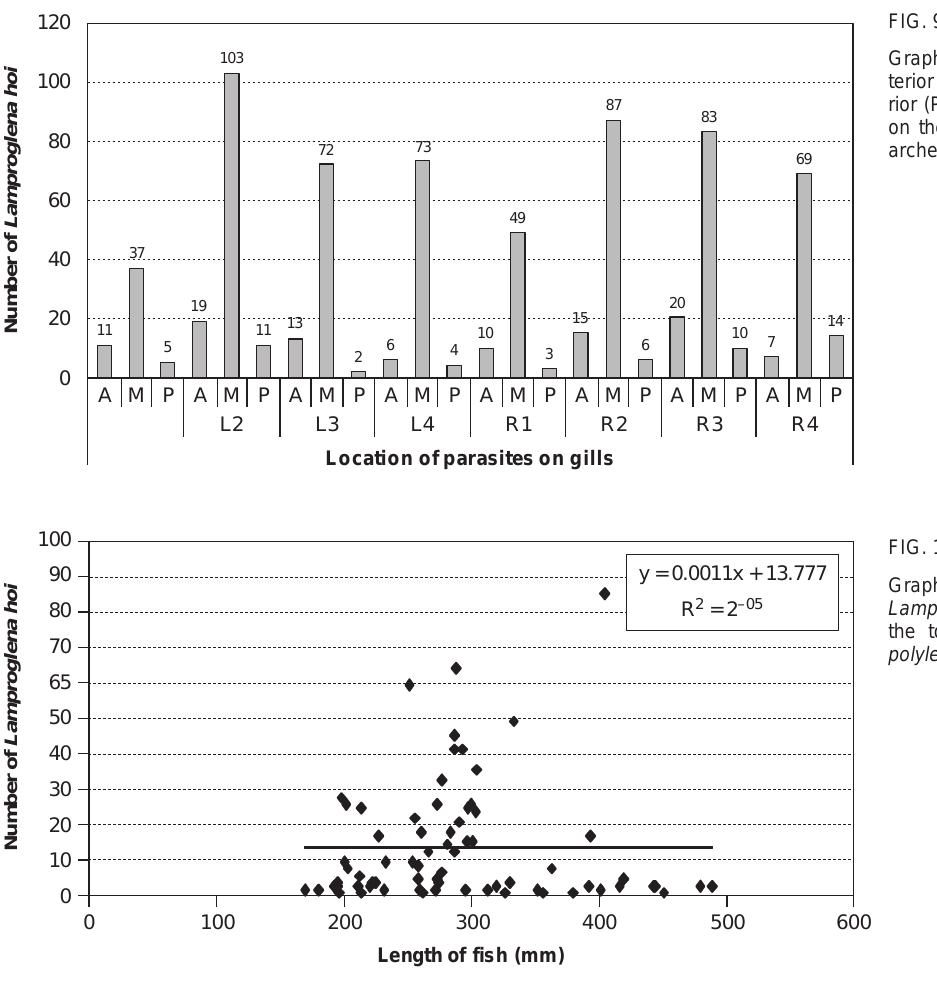
Graph showing the position (an- terior (A), median (M) or poste- rior (P)) of the Lamproglena hoi on the left (L) and right gill (R) arches of Labeobarbus polylepis